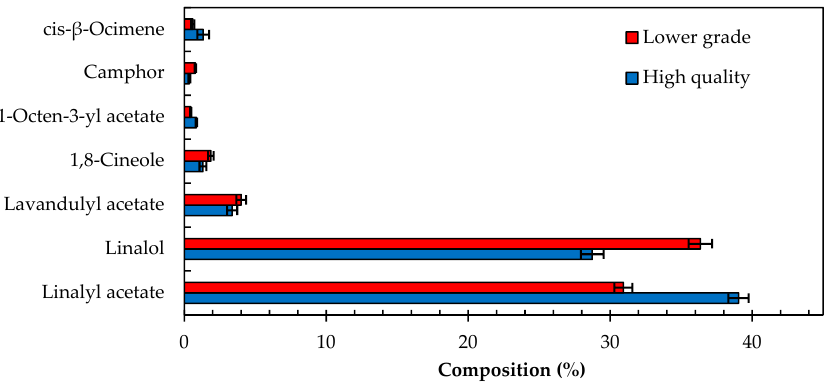
Figure 1. Comparison of target compounds found in the reference sample in the high quality and lower grade lavender oil samples analyzed. The data presented is derived from the analysis of 54 oil samples, 30 qualified as high quality and 24 qualified as lower grade lavender oil. Error bars are indicative the standard deviation of the cohort.